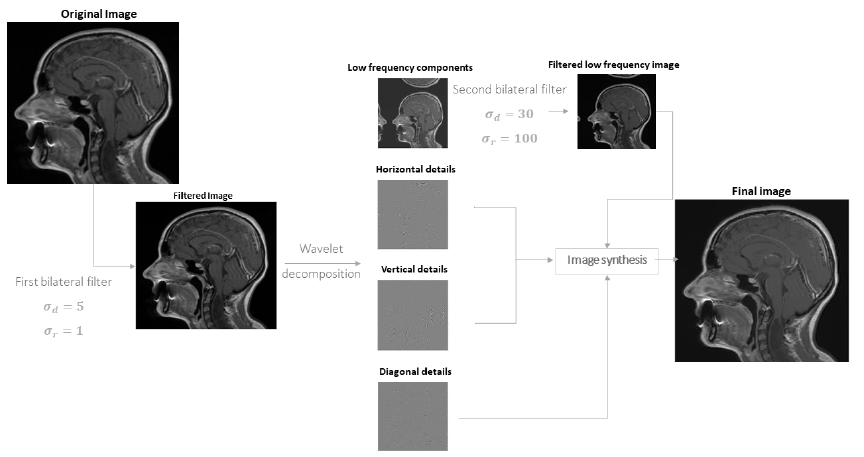
Figure 2. Pre-processing by bilateral filter and wavelet.